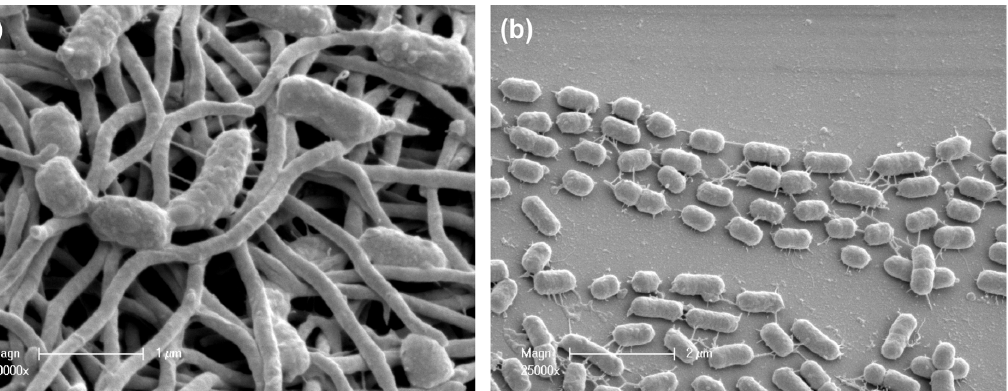
Figure 5. SEM micrographs of polymicrobial biofilms involving P.gingivalis W50ABK mutant, T.denticola and T.forsythia . The left pannel shows P. gingivalis W50ABK mutant cells associated with a T. denticola microcolony and the right pannel shows P. gingivalis cells at the outer edge of a T. denticola microcolony. It has been confirmed by FISH that no T. forsythia was detected in these biofilms (data not shown).